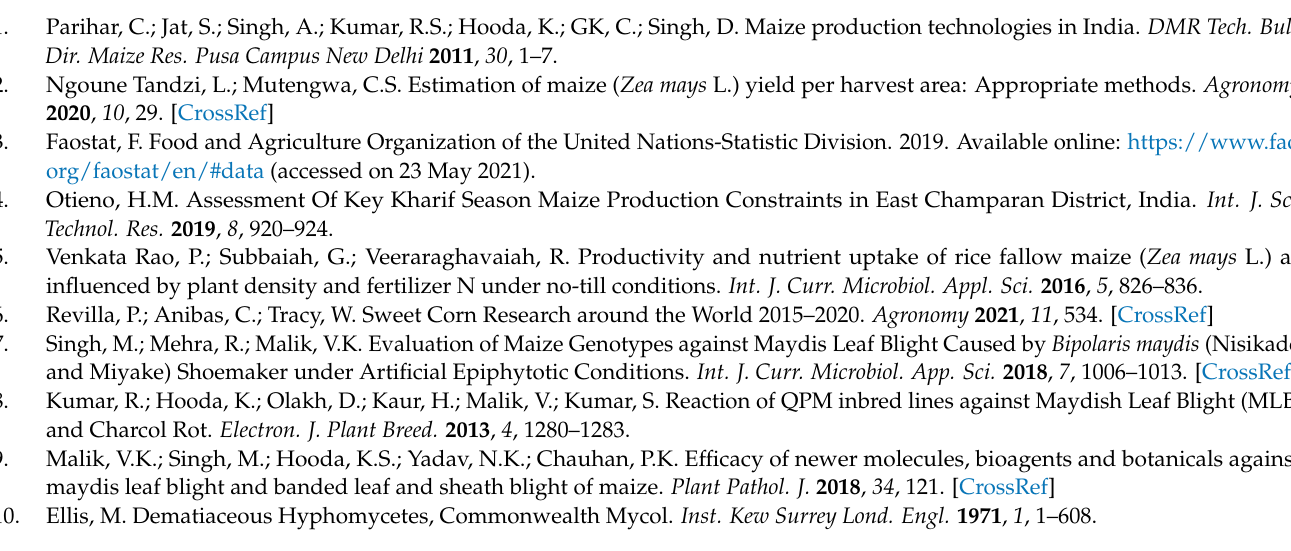
Map of India.; Figure S2: Representative Bipolaris isolates showing the morphological description from Group A to E; Figure S3: Scanning electron microscope showing conidiophore, conidia and hilum of Bipolaris isolates; Figure S4: Representative isolates of Curvularia spp. showing the morphological descriptions from Group F- Group J; Figure S5: (5a-a) Pot experiment for pathogenicity proving of maize leaf spot (b) maize leaf spot. symptomatic leaves (c) Fully grown Curvularia lunata culture plate (d) Microscopic image of conidia of Curvularia lunata at 40X; (5b-a) Pot experiment for pathogenicity proving of maydis leaf blight (b) maydis leaf blight symptomatic leaves (c) Fully grown Bipolaris maydis culture plate (d) Microscopic image of conidia of Bipolaris maydis at